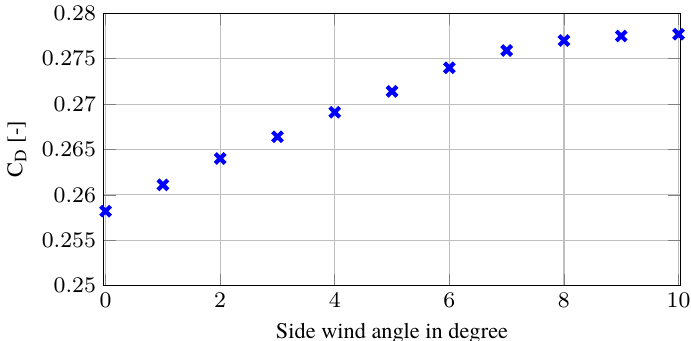
β SW 10 ◦ and β SW 10 ◦ and ≤ ≤ ≤ ≤